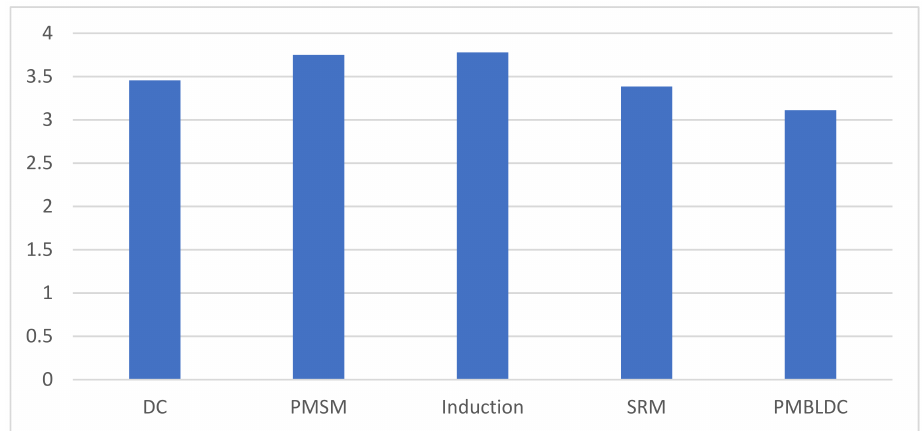
Figure 19. Global results of the motor type’s